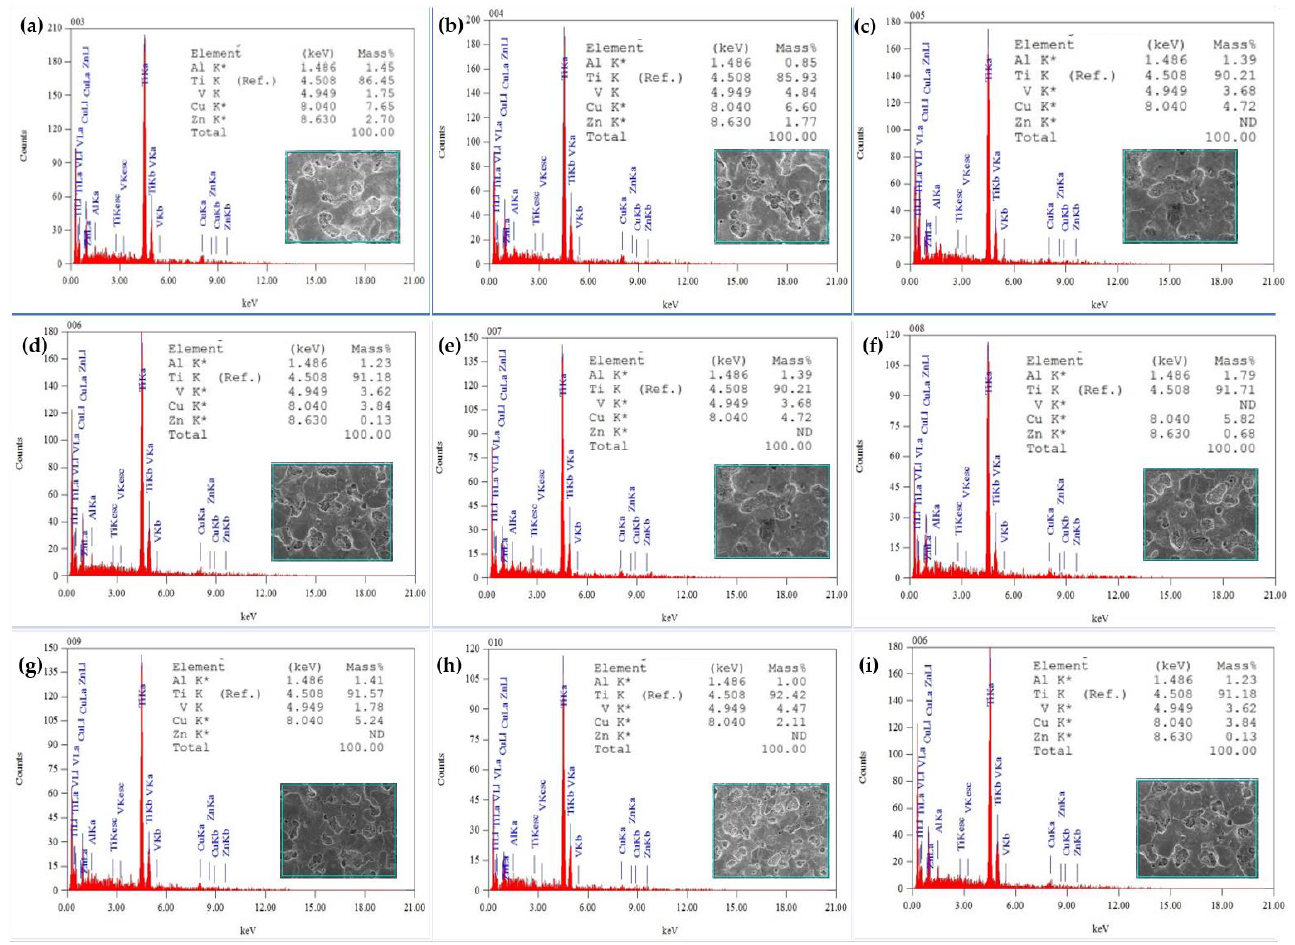
Figure 8. EDC Coating Surface EDX: ( a ) EX 1, ( b ) EX 2, ( c ) EXP 3, ( d ) EX 4, ( e ) EX 5 and ( f ) EX 6, ( g ) EX 7, ( h ) EX 8 and ( i ) EX 9.